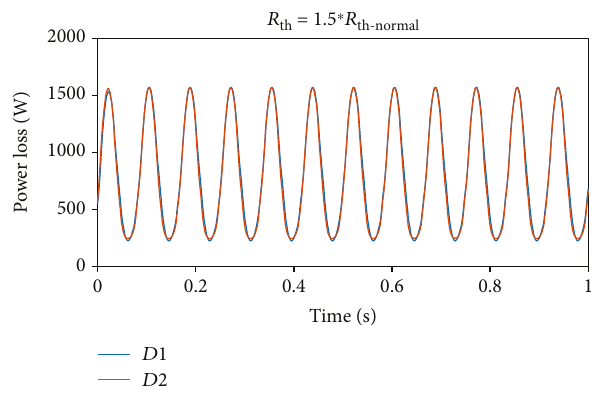
Figure 4: Power losses of parallel-connected power modules ( D 1 aged to 1 5 ∗ R th − normal